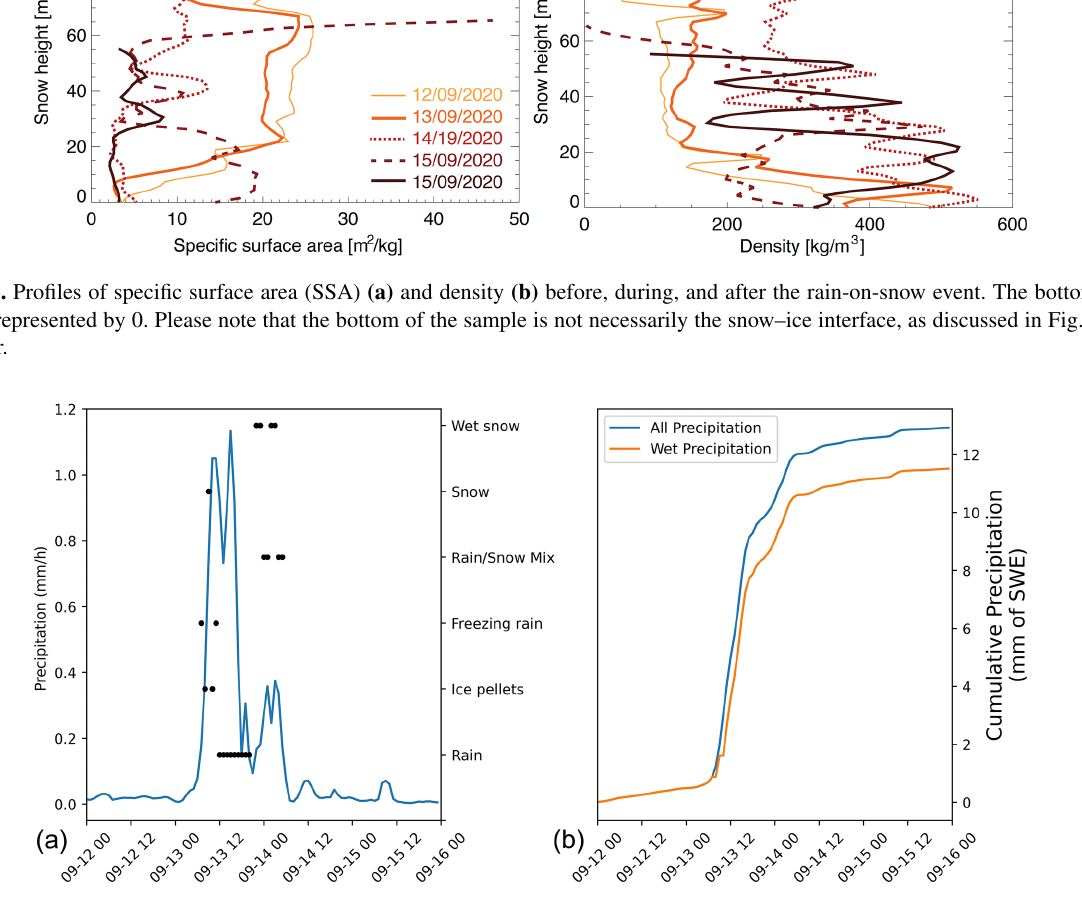
Figure A3. Rain on snow from ERA5 data. (a) Time series of cumulative precipitation at the MOSAiC floe (nearest 1 ◦ grid cell) separated into all precipitation and wet precipitation , where the latter corresponds to all World Meteorological Organization precipitation types that are not snow or ice-pellets. (b) Time series of precipitation and precipitation type as in (a)